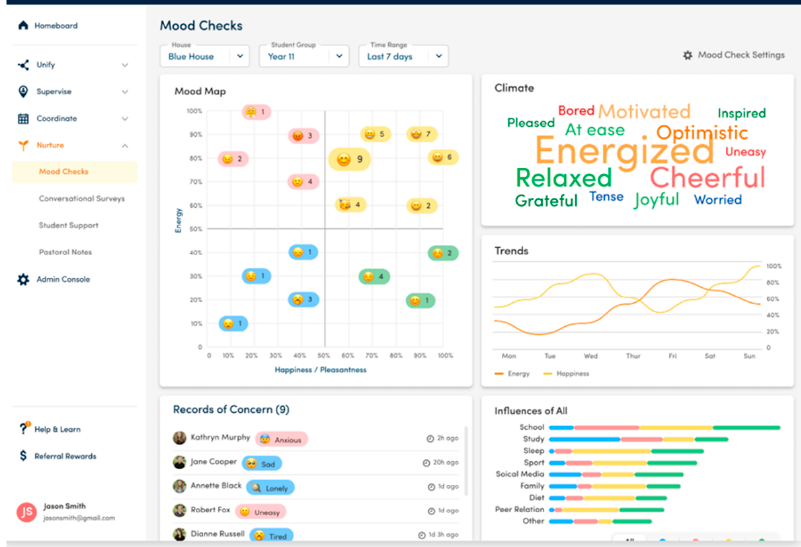
Figure 8. Mood Map—Nurture Beta Web Platform.